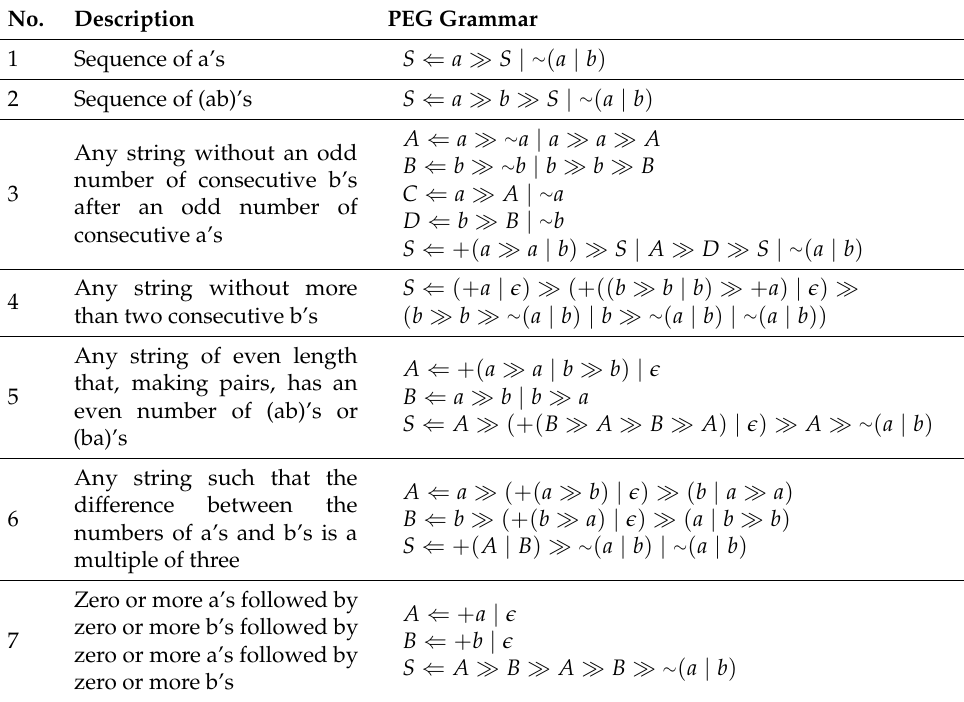
Table 2. PEG expressions created based on Tomita (1982)